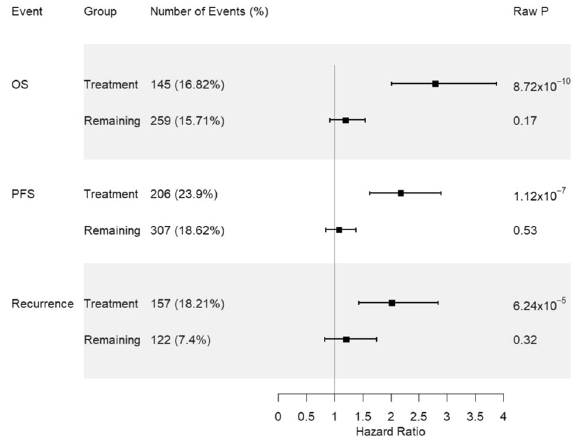
Fig. 4 Association of rs720251 with OS, PFS, and breast cancer recurrence in the Pathways European population. The “ treatment ” and “ remaining ” group correspond to patients received Par-4 dependent chemotherapies and the remaining patients, respec- tively. The estimated hazard ratio as well as its 95% con fi dence interval were plotted. Raw P -values from the corresponding cox models were given for direct comparison across outcomes.